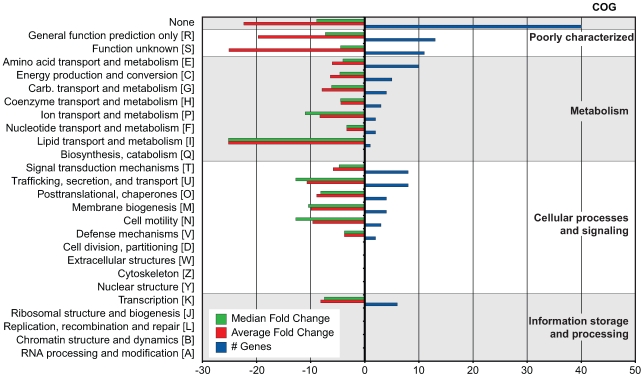
COG analysis of 133 genes co-regulated with SPI-2.COG categories are indicated to the right of the figure and COG sub-categories are ordered in terms of decreasing gene representation (blue) within each category. Median and average fold change values for each sub-category are indicated in green and red, respectively.